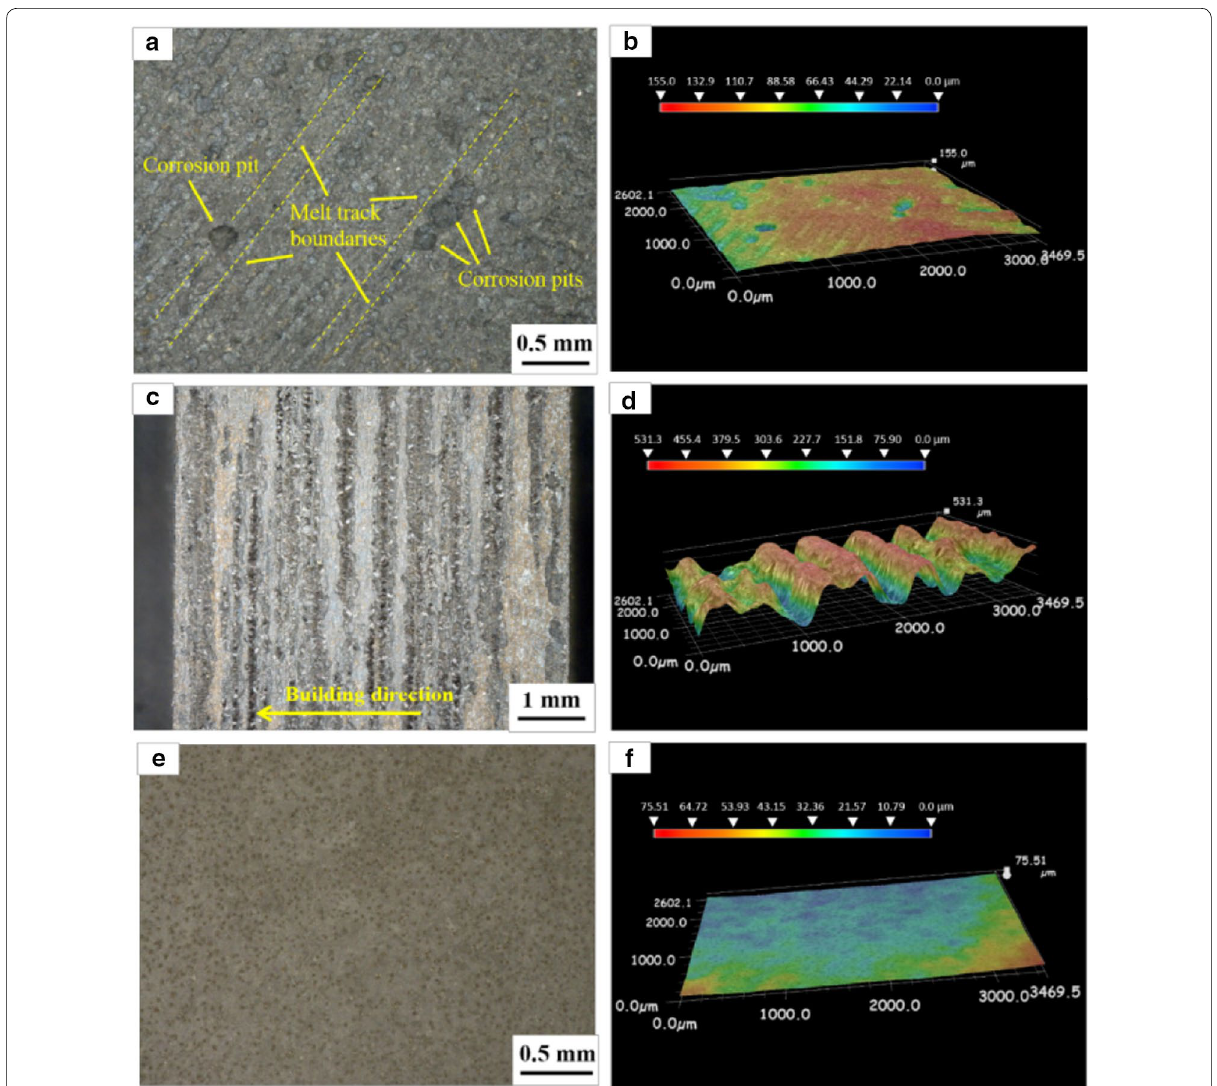
Figure 8 Surface photographic and digital microscopic images of specimens immersed in 6% FeCl 3 c , d side view of as‑SLM samples; e , f casting